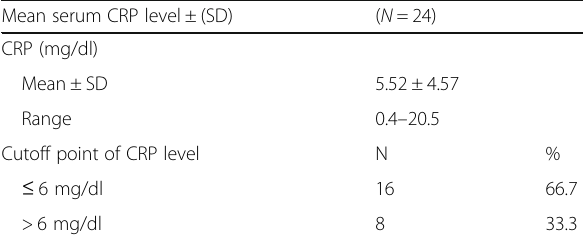
Table 2 Mean serum CRP level (mg/dl) in the studied GBS cases